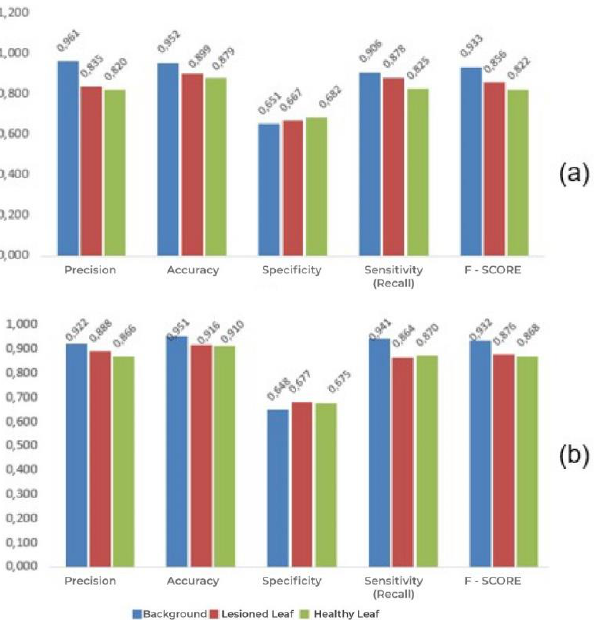
Figure 6. Report of the performance of the two CNN models for each class: ( a ) Google Net and ( b ) ResNet50.